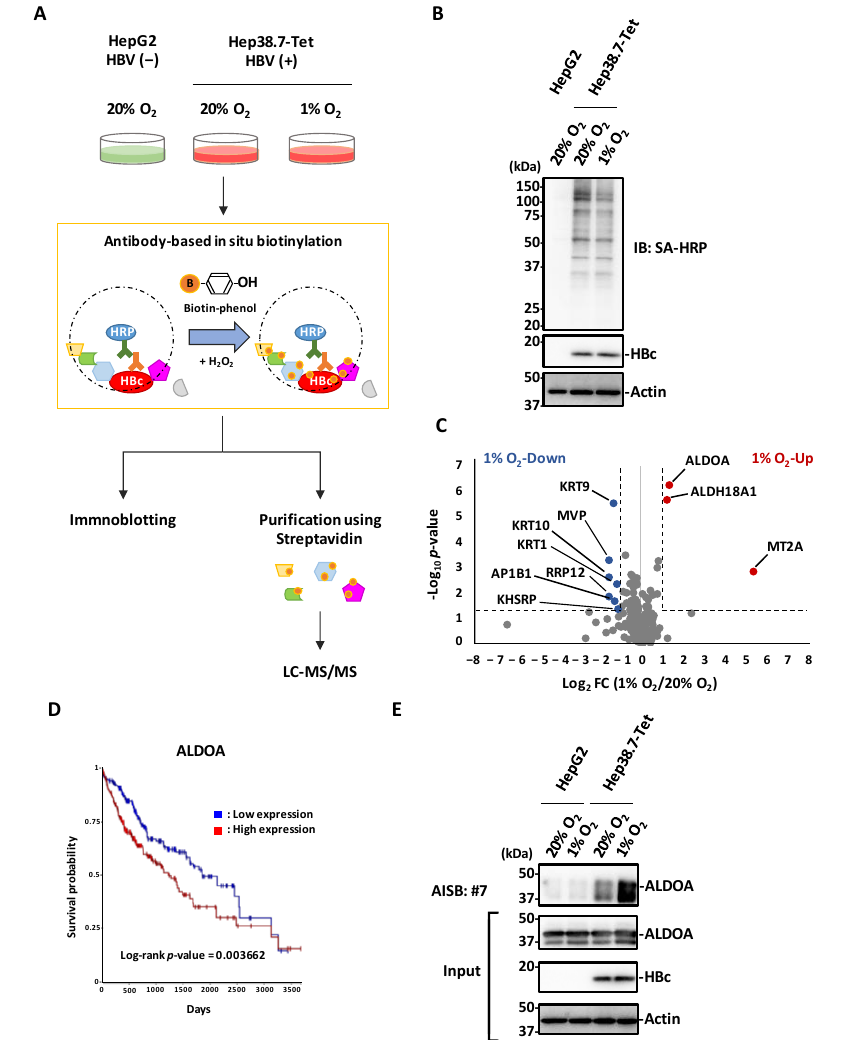
Figure 5. Antibody-based in situ biotinylation analysis with mAb #7. ( A ) Schematic of proteomic analysis for the identification of host proteins that interact with HBc in HBV-positive (Hep38.7-Tet) and HBV-negative (HepG2) cells under normoxic and hypoxic conditions. Each cell was fixed and permeabilized. After mAb #7 bound to HBc, the proximal portion of HBc was biotinylated by adding biotin-phenol and H 2 O 2 . The cell extracts were analyzed by immunoblotting, followed by mass spectrometric analysis of the biotinylated proteins. ( B ) Biotinylation of each cell extract was confirmed by immunoblot analysis with Streptavidin HRP Conjugate. ( C ) Volcano plot representing differences in abundance of 215 host proteins near HBc under normoxic and hypoxic conditions. The x -axis indicates the log 2 fold change and the y -axis indicates the –log 10 p -value based on the two-tailed Student’s t -test. The proteins that were significantly upregulated (red) or downregulated (blue) under the hypoxic condition were identified based on two criteria: |fold change| > 2 and p -value < 0.05. The dotted lines show the criteria. FC, fold change. ( D ) Kaplan-Meier analysis of ALDOA was performed using the UCSC Xena platform and mRNA sequence databases of the Cancer Genome Atlas Program (TCGA). Log-rank p = 0.003662. Log-rank p -value < 0.05 was regarded as statistically significant. The x -axis indicates the days and the y -axis indicates the survival probability. ( E ) HBc interacts with ALDOA. The streptavidin-purified biotinylated samples were analyzed by immunoblotting with anti-ALDOA antibody. AISB, antibody-based in situ